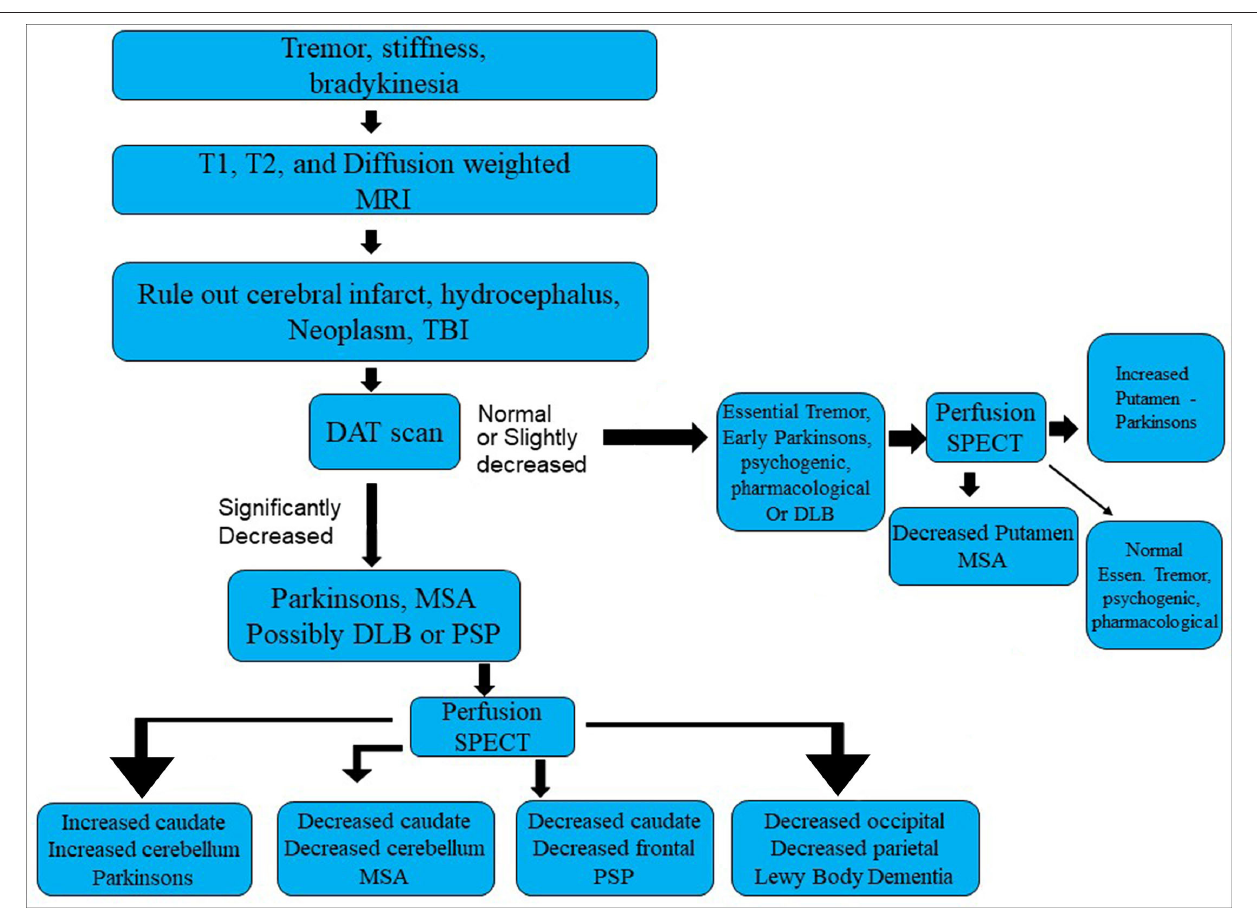
FIGURE 7 | Flowchart for evaluation of Parkinsonian syndromes.